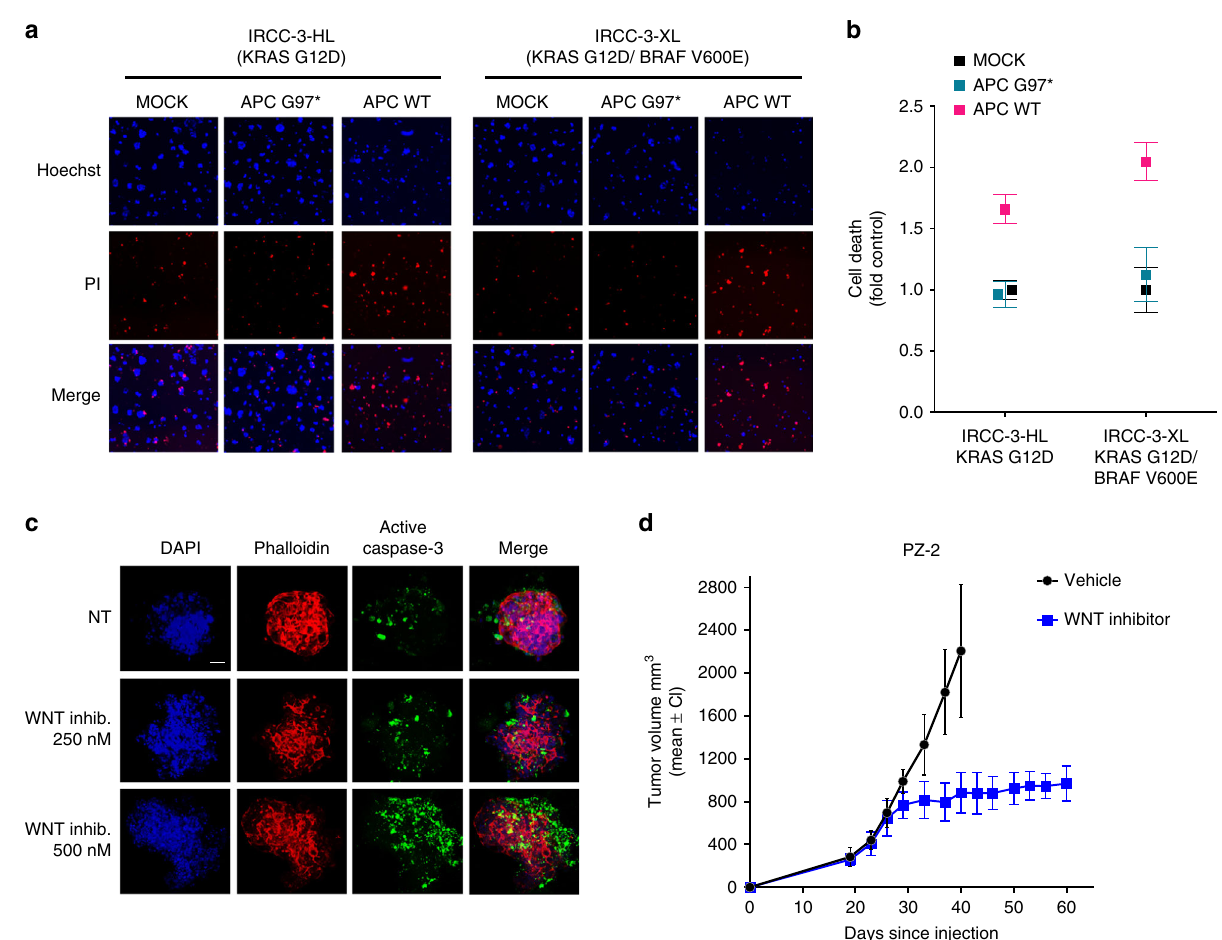
Fig. 5 Cells and organoids from drug-resistant CRC patients rely on the WNT/ β ‐ catenin pathway. a Primary 2D cell lines, established from the tissue specimen collected from a CRC patient whose tumour developed secondary resistance to anti-EGFR therapy (see detailed methods section), were electroporated with a plasmid encoding for WT APC or an inactive APC version (G97*). Electroporation buffer was used as the control (mock). After 48 h, cells were stained with Hoechst 3342 /Propidium Iodide (PI) to detect cell death. A representative image of a single 96-well is shown for each condition. b Relative quanti fi cation of Hoechst/PI positive cells was made using ImageJ software and normalised against mock cells. Results represent means± SD of three independent wells. c 3D organoids established from a CRC patient whose tumour developed secondary resistance to EGFR-BRAF combinatorial treatment (see detailed methods section), were treated with LGK974 for 2 weeks. Representative confocal microscopy images showing active cleaved caspase-3 (green) are shown. Nuclei are stained with DAPI (blue) and actin with Phalloidin (red). Maximum projection of a 10 image stack along the z -axis. Scale bar: 50 μ m. d Patient-derived mice models (xenopatient) were established from a tumour obtained from a metastatic colorectal cancer patient (PZ-2) resistant to EGFR/BRAF combinatorial treatment. Upon successful engraftment, mice were randomised to vehicle ( n = 6) or LGK974 (WNT inhibitor) ( n = 6) treated arm. Results represent tumour mass volume (mm 3 , mean ± CI of individual tumour